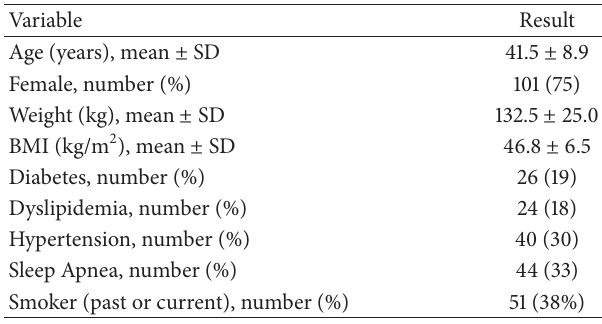
Table 1: Baseline characteristics.